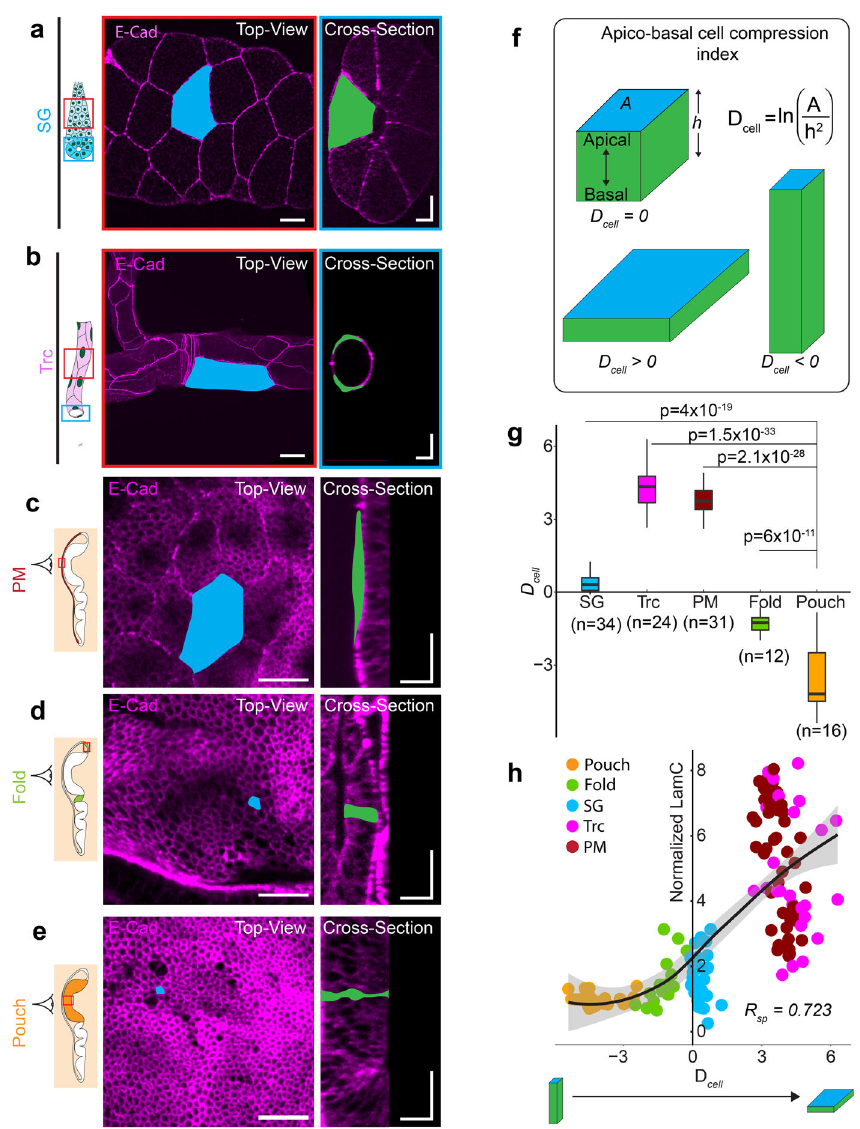
Fig. 2 Lamin C scales with apico-basal cell compression in epithelial tissues. Schematic representation of the salivary gland ( a ) and trachea ( b ) with the region imaged marked by the red and blue ROIs. Images show the top view (red ROI) and cross-section view (blue ROI) of the SG and trachea expressing E-Cad GFP (magenta). A representative cell is shown with apical area marked in blue and apico-basal area marked in green. Scale bar in top-view images in ( a ) and ( b ), 25 µ m. Scalebar in cross-section images, 25 µ m along both axes. c – e Cell morphology in different regions of the wing disc. PM of the wing disc is colored in dark red ( c ). The fold is colored in light green ( d ), and the pouch is colored in orange ( e ). Images show the top view and cross-section view of each wing disc region expressing E-Cad GFP (magenta). A representative cell is shown with the apical area marked in blue and apico-basal area marked in green. Scale bar in top-view images, 15 µ m. Scale bar in cross-section images, 15 µ m along both axes. f Schematic representation of cell deformation index ( D cell ) for epithelial tissues. D cell for a cube is 1, whereas D cell for a cuboid elongated along the apico-basal axis is <1 and a cuboid compressed along the apico-basal axis is >1. g Box-plot of D cell for different epithelial tissues of Drosophila . The sample number, n represents the number of cells analyzed across 10 different tissue samples. h Scatter plot between D cell and normalized levels of LamC. Each point in the scatter plot represents an individual cell in different Drosophila tissues. Solid black line represents the LOESS regression of the data. The Spearman rank correlation coef fi cient, R sp is 0.723. P values are estimated by one-way ANOVA and the p values are shown for comparison with the D cell value in the